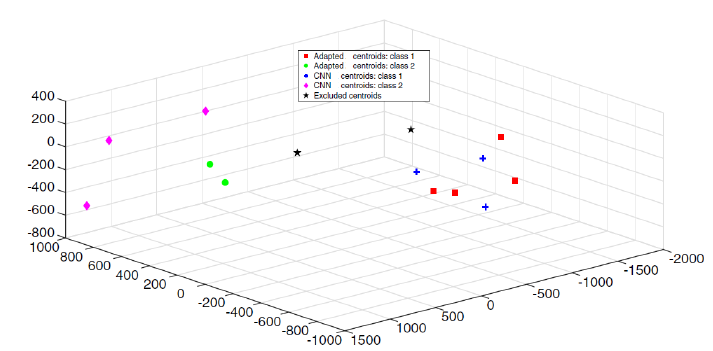
Figure 11. 3-D visualization of the adapted, constant and excluded cluster centroids; class 1 (2) includes good (bad) quality